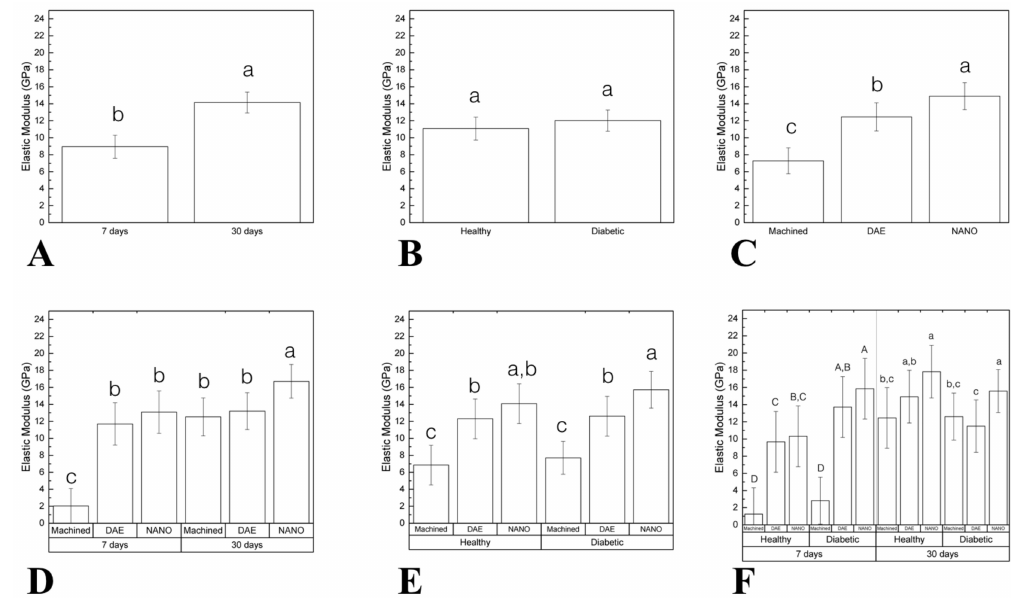
Figure 6. ( A – F ) Graphs representing elastic modulus (EM) di ff erently arranged as a function of study factors (mean and 95% CI). A significant di ff erence was seen between 7 and 30 days in vivo ( A ). No statistically significant di ff erence was found when comparing the healthy and diabetic group (data as a function of systemic condition) ( B ). When the implant surface was considered, NANO group exhibited higher EM relative to machined and DAE groups (data as a function of implant surface) ( C ). Data evaluation as a function of time and implant surface highlighted the superiority of NANO group at 30 days compared to others ( D ). When EM was evaluated as a function of systemic condition and surface, diabetic NANO group depicted higher values ( E ). Evaluating all factors: time, systemic condition and surface treatment the results revealed that surface treated implants presented superior EM than machined ( F ). Identical letters indicate no significant di ff erence among